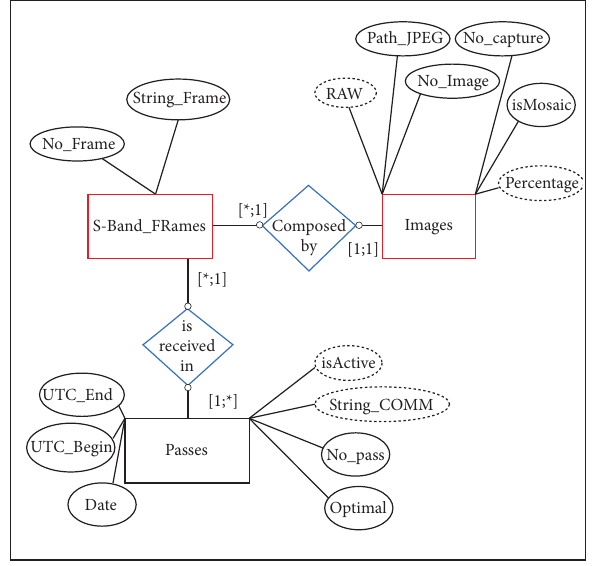
figure 15. Some entities of the GSCM&C data model.